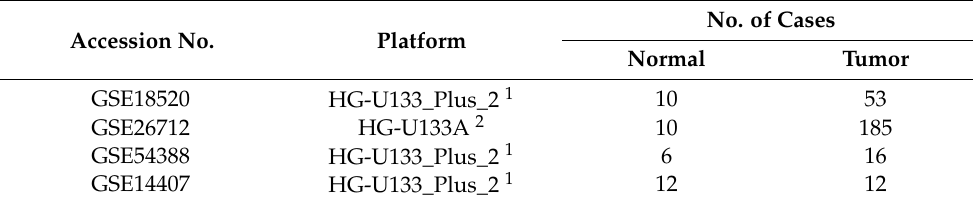
Table 1. Microarray datasets of ovarian cancer